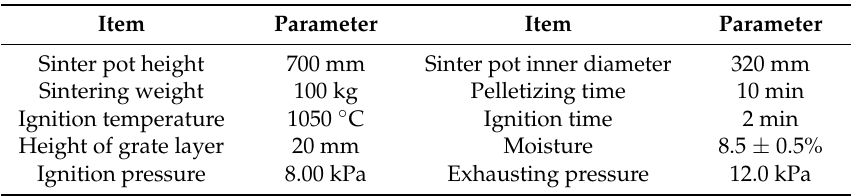
Table 2. Experimental scheme and ingredient of sinter materials (wt %).